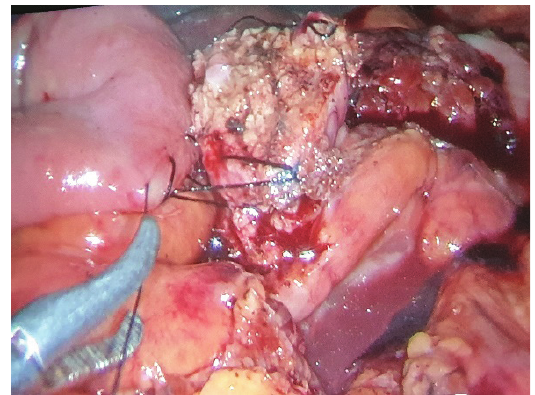
Figure 3: Hepaticojejunostomy